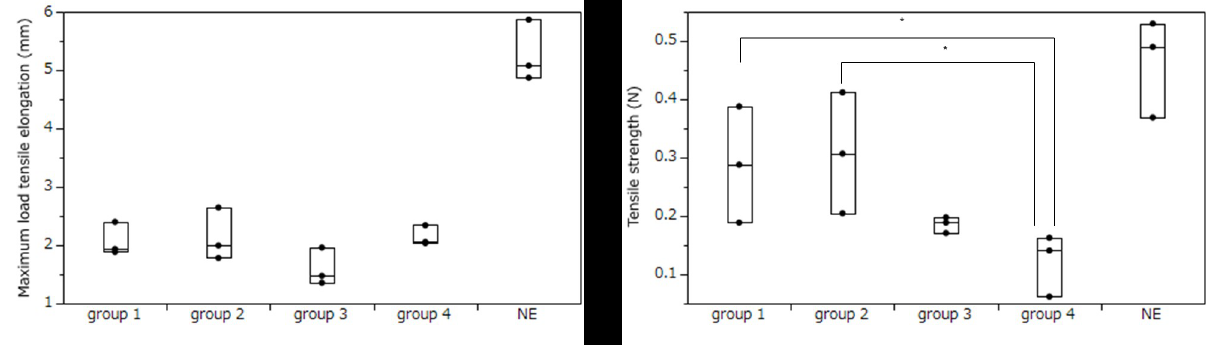
Fig 2. Mechanical characteristics of structures made by the bio-3D printer. A. Maximum load tensile elongation B. Tensile strength The mechanical data of the structures measured by a Tissue Puller.